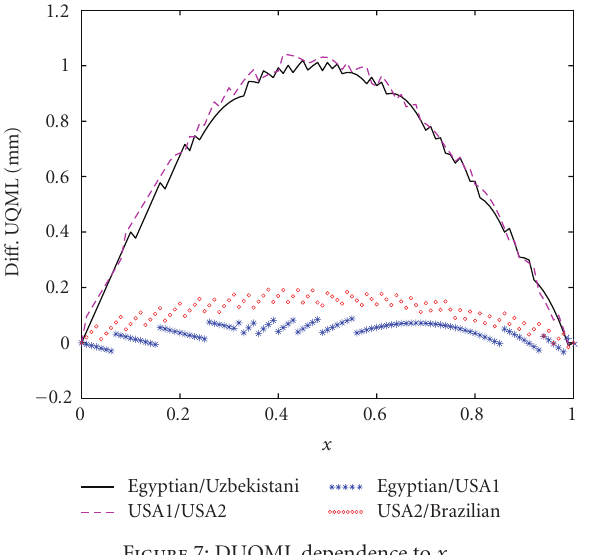
Figure 9: DSL 50% dependence to x .